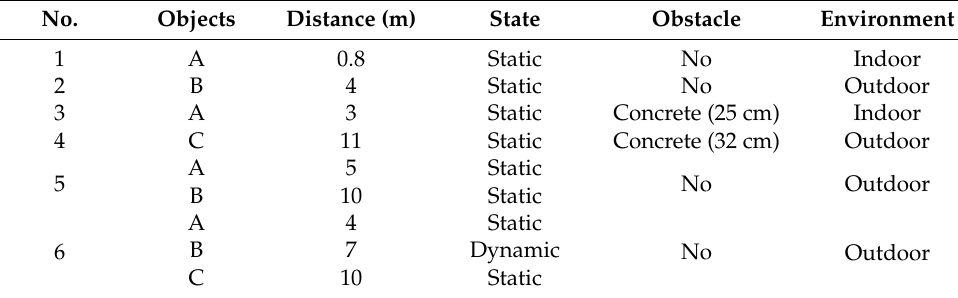
Table 6. Settings of different experimental groups.